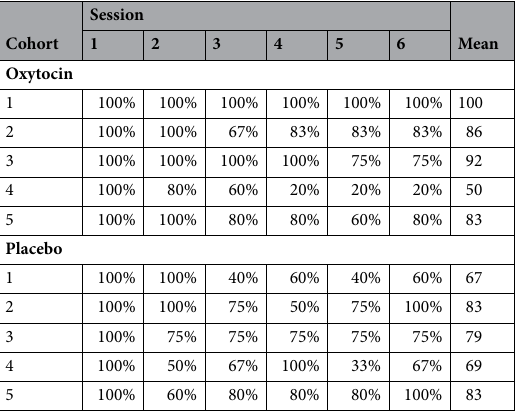
Table 2. Percentage of participants per cohort attending each